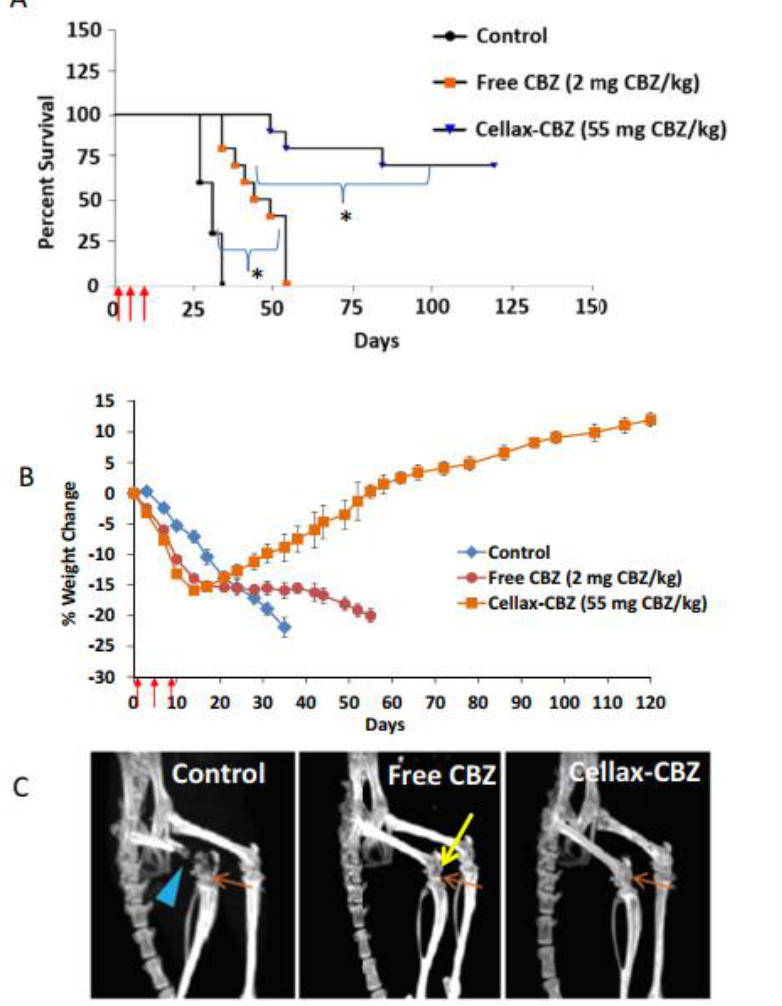
Figure 3. In vivo efficacy of free cabizataxel (CBZ) and Cellax-CBZ in a model of treatment-resistant bone metastatic PCa. Mice received intrafemoral injections of C4-2B-RES cells and were treated with CBZ (2 mg/kg, q159d), Cellax-CBZ (55 mg CBZ/kg, q159d), or saline control ( n = 10 per group). Body weight loss, behavioral changes, and survival were monitored over time. Kaplan–Meier survival curves are shown in ( A ), and body weight changes are shown in ( B ). Arrows indicate injection days. * p < 0.05. Representative microCT images of mice from each treatment group 4 weeks after the initial dose are shown in ( C ). Orange arrows indicate tumor cell injection sites; the blue arrowhead indicates complete bone loss; and the yellow arrow indicates mild bone loss. (Adapted with permission from [159]).